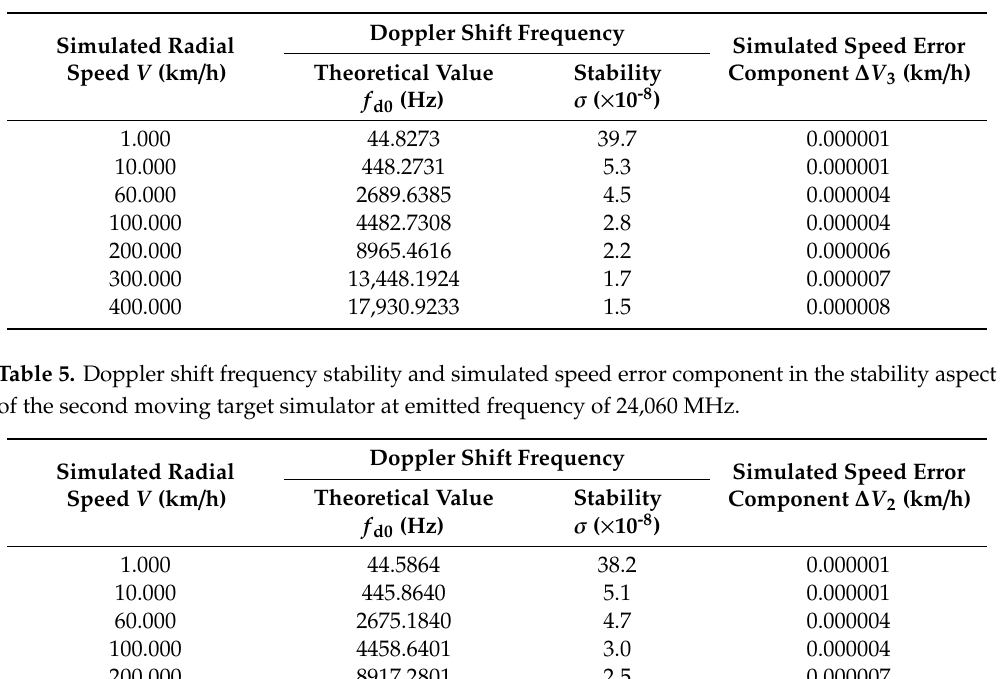
Table 4. Doppler shift frequency stability and simulated speed error component in the stability aspect of the first moving target simulator at emitted frequency of 24,190 MHz.